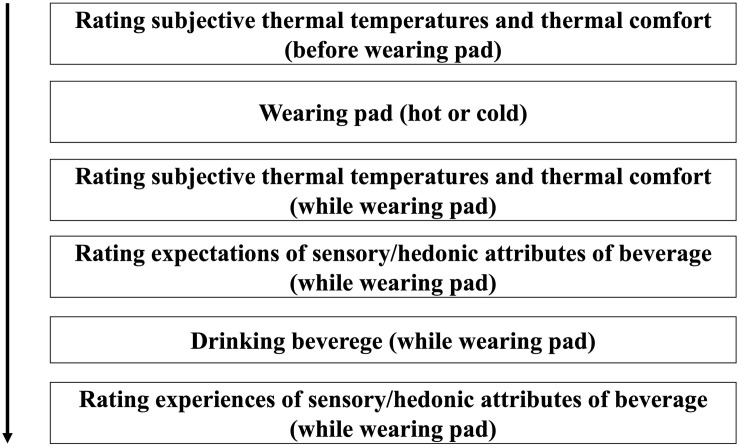
Timeline for the experimental procedure. The procedure was repeated in the other condition (hot or cold), and the order of the conditions was randomly allocated.